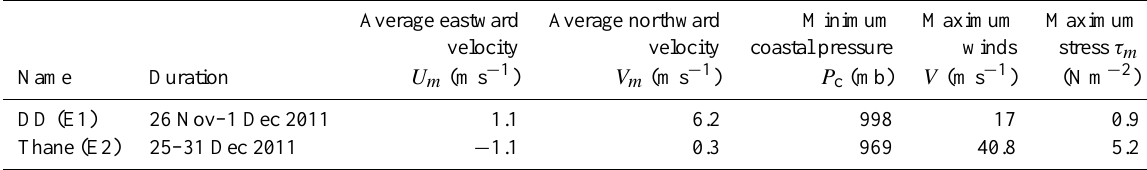
Table 6. Parameter estimates of the events E1 and E2.